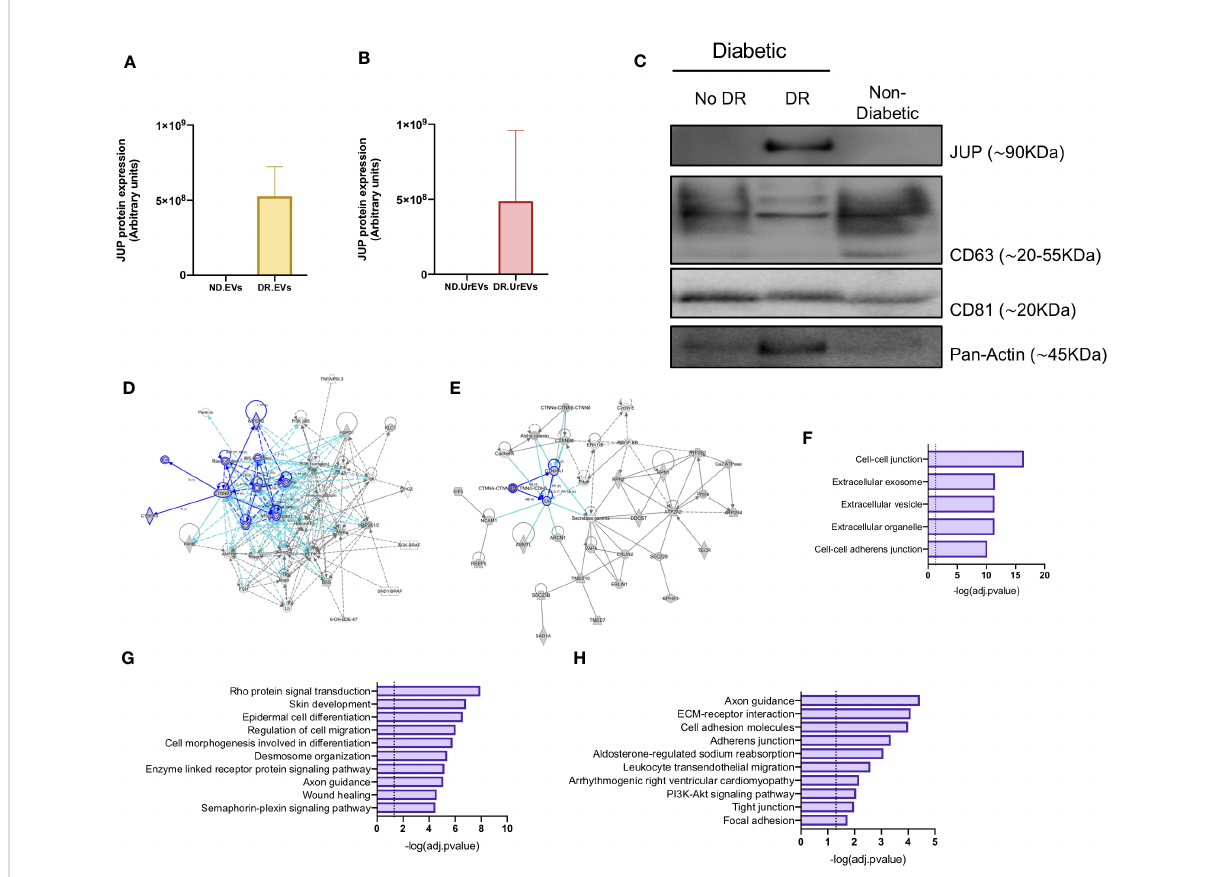
FIGURE 5 Validation of JUP as a potential biomarker for diabetic retinopathy. JUP protein levels in retinal EVs (A) and urinary EVs (B) from Non-diabetic and Diabetic patients, obtained from the proteomic datasets. (C) JUP, CD63, CD81 and Pan-Actin levels in urinary EVs pooled from Non-DR, DR and Non-Diabetic patients. Each lane contains 30ug of EV proteins obtained from a pool of three independent samples. A network diagram representing protein-protein interaction showing (D) proteins that are involved in the organization and disruption of anchoring junction and (E) proteins involved in the development of vasculature. (F) Prediction analysis to determine protein subcellular localization. Pathway (G) and biological process (H) enrichment analysis of shared proteins between DR.EVs and